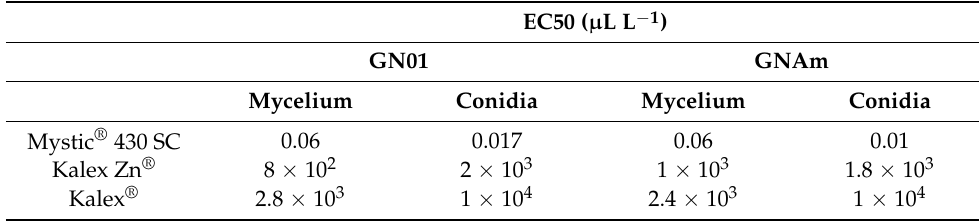
Table 2. Values of 50% effective concentration (EC50) for inhibition of radial growth and conidia germination of 2 isolates (GN01 and GNAm) of Gnomoniopsis castaneae by Mystic ® 430 SC, Kalex Zn ® and Kalex ® .